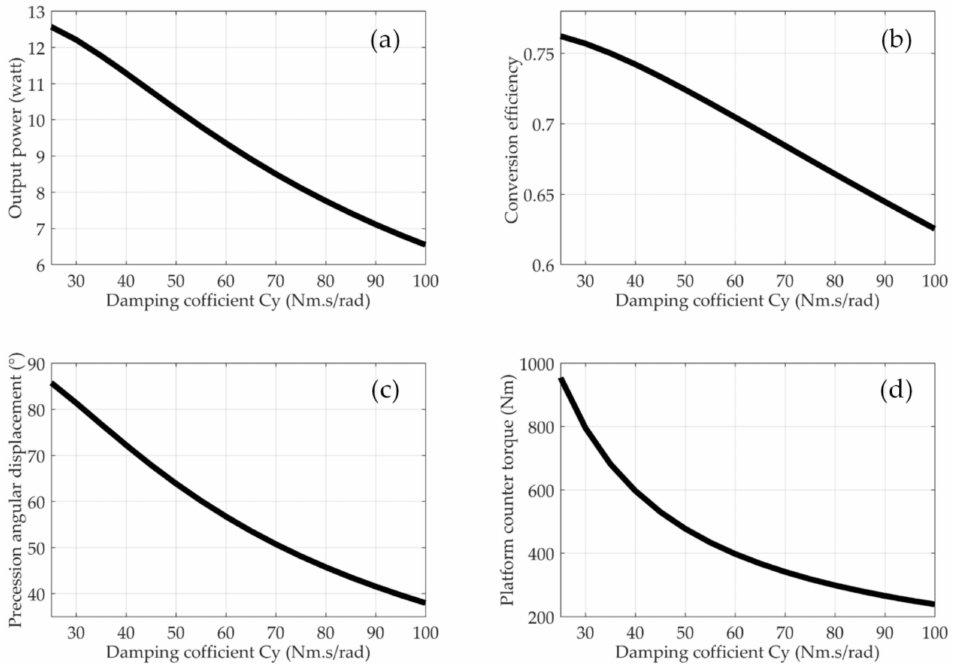
Figure 9. Effect of the PTO damping coefficient: ( a ) output power; ( b ) conversion efficiency; ( c ) fly- wheel precession angular displacement; ( d ) platform counter